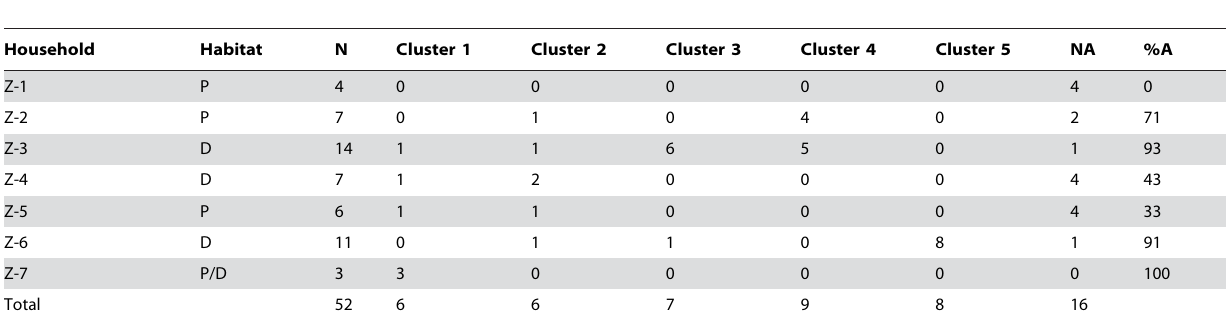
Table 6. Assignment of individuals from 7 households in Zurima to genetic populations through Bayesian